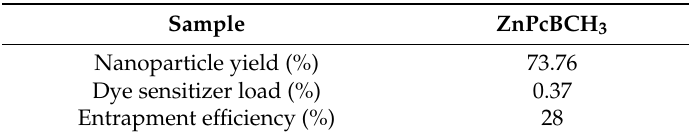
Table 4. Nanoparticles yield, sensitizer load, and entrapment efficiency obtained from nanoprecipitation using